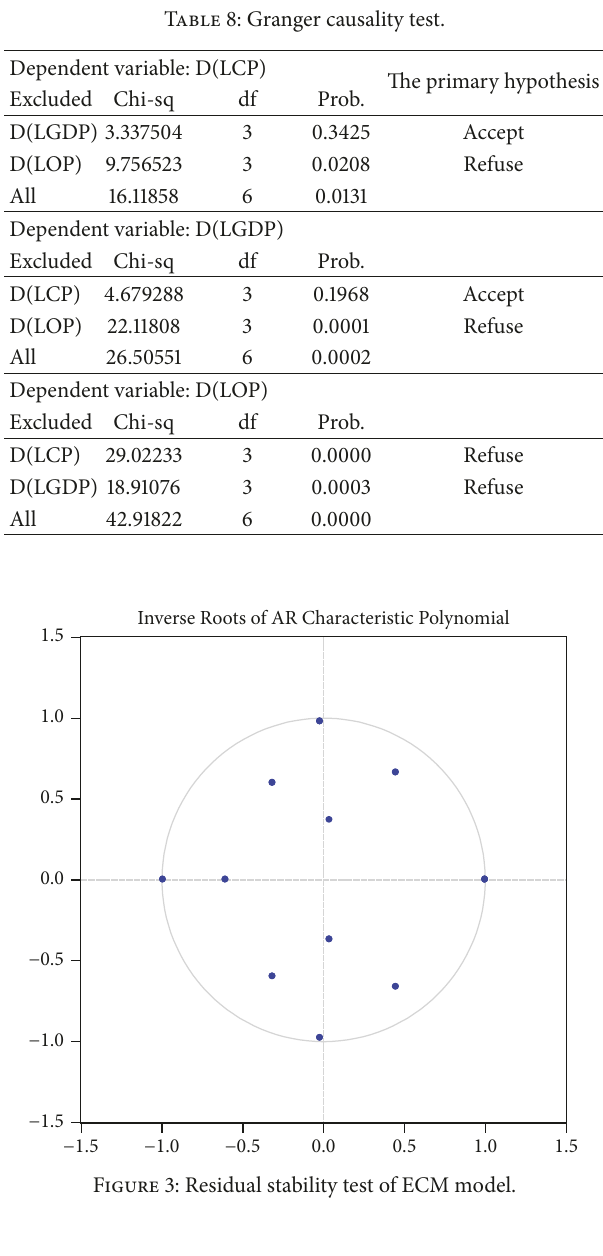
(Figures 3-4). On the whole, the VECM model has good